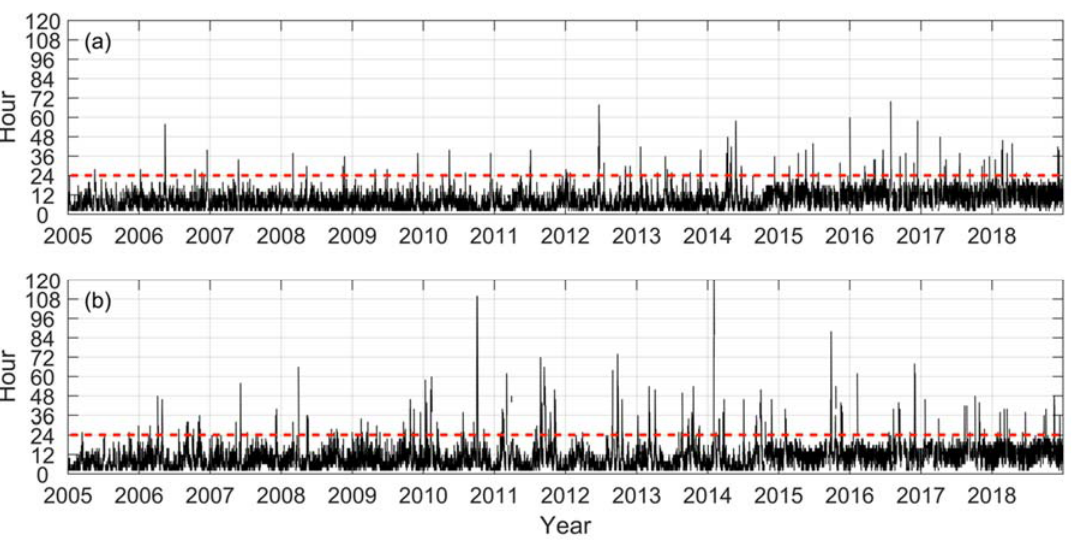
Figure 3. Time series of the persistent duration of ( a ) the negative and ( b ) positive TEC anomalies. The dashed red line indicates the criterion of 24 h. 1.45% of the positive anomaly and 3.78% of the negative anomaly persist longer than 24 h.